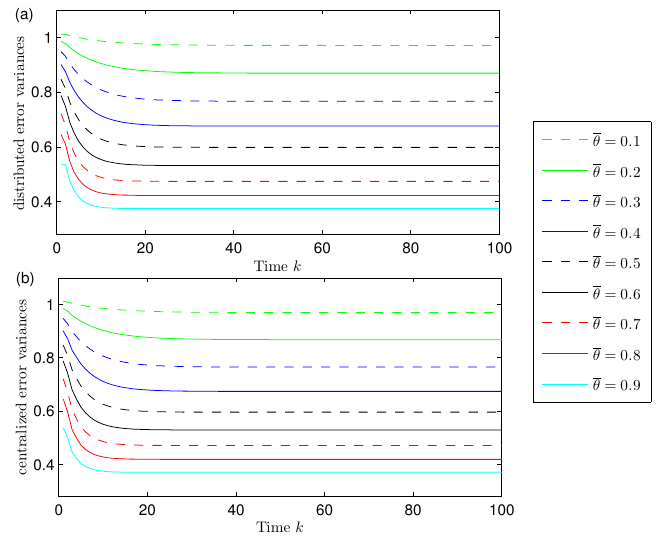
Figure 2. ( a ) Distributed and ( b ) centralized filtering error variances for different values of θ , when γ ( i ) = 0.21, i =